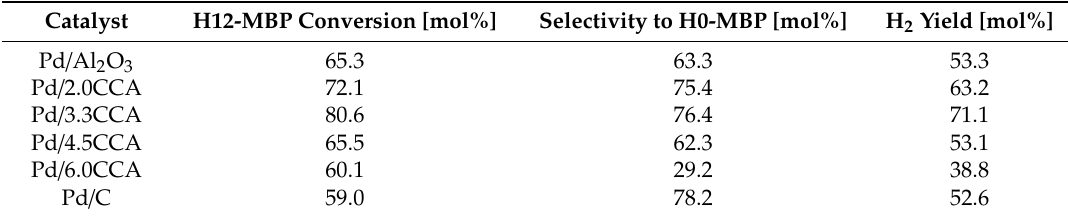
Table 2. Activity results in the dehydrogenation of H12-MBP at 250 ◦ C for 4 h [a].